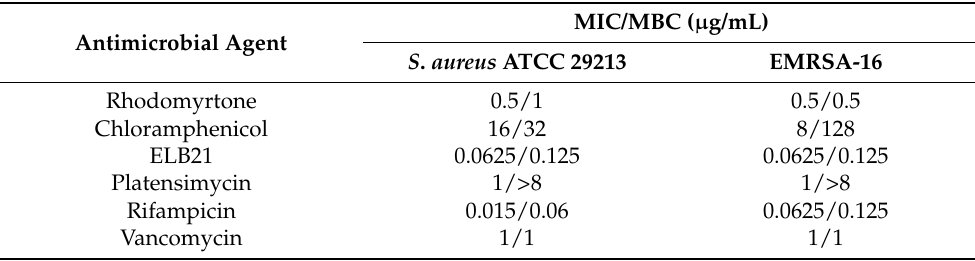
Table 1. Minimum inhibitory concentrations and minimum bactericidal concentrations of rhodomyr- tone and standard macromolecule inhibitors on Staphylococcus aureus ATCC 29213 and